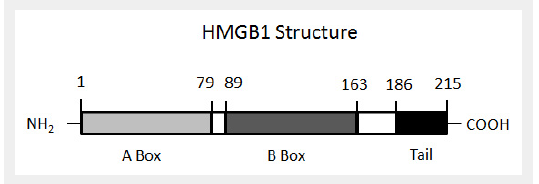
The structure of HMGB1. The figure illustrates the molecular structure of HMGB1, demonstrating the presence of two boxes (A and B) and the C-terminal